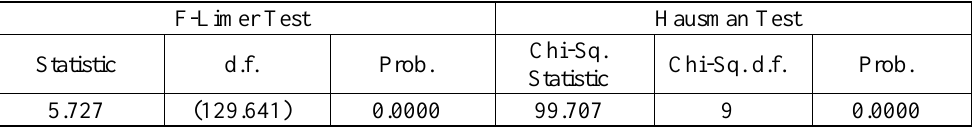
Table 3. Model type selection Test